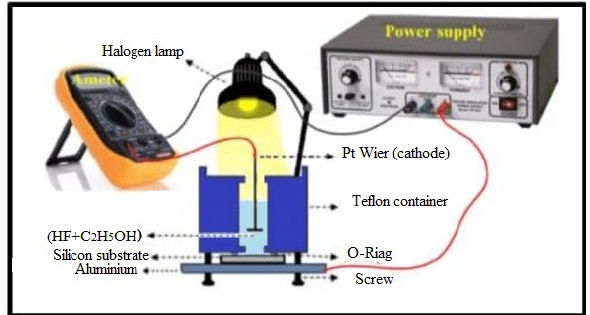
Figure 1: A schematic diagram of PECE set up for porous silicon at different etching current densities, etching time 10min, and HFC